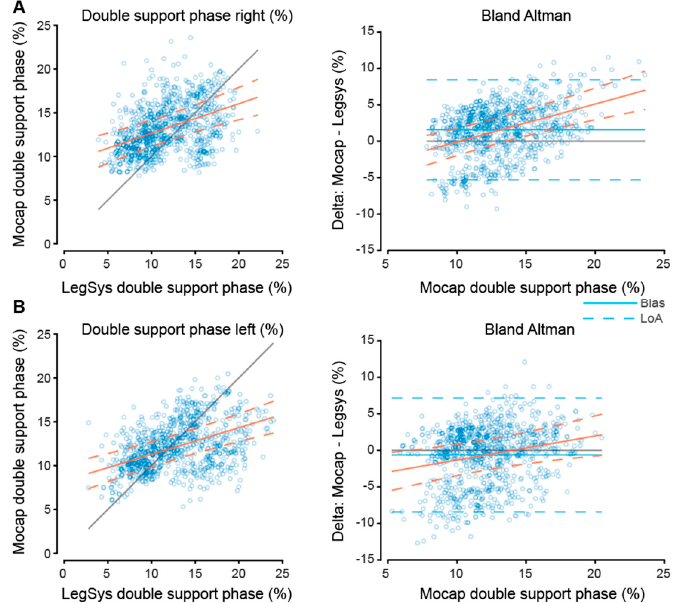
Figure A2. Scatter and bland-Altman plot of MOCAP vs. LEGSYS for double support phase (%). Part A and B shows the scatter plot and bland-Altman plot on the left and right. For the scatter plot, the blue dots show double support for each system. The bland-Altman plots show the difference between the MOCAP and LEGSYS parameters on the Y axis and MOCAP double support. Blue line and dotted blue line show the bias and limits of agreement respectfully. The orange line on all 4 plots shows the least squares regression lines with orange dots being the 95% confidence interval.